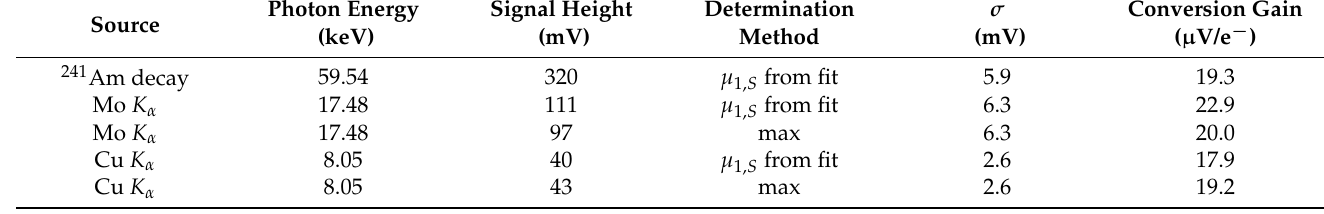
Table 4. Signal height and conversion gain for different X-ray energies and photons from Am decay. The signal height is either extracted as the mean of an error function fit or the position of the maximum differentiation value. The method is marked accordingly. σ is the standard deviation of the background noise peak.